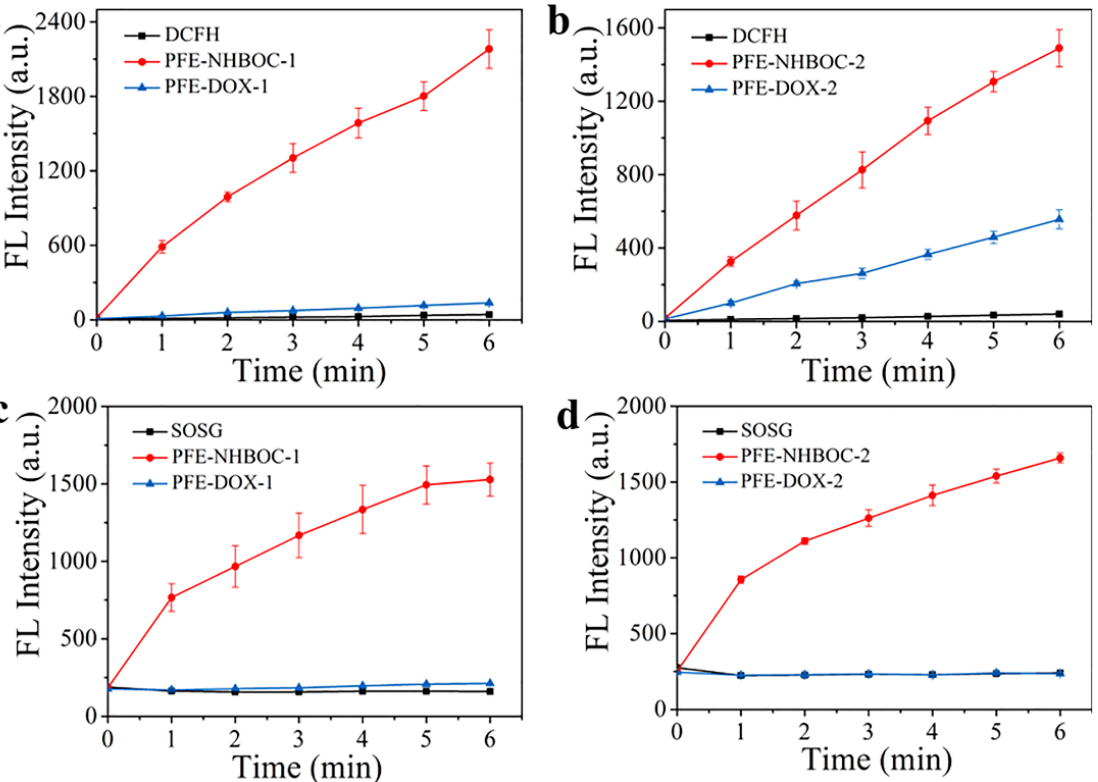
Figure 3 . Fluorescence intensity of DCFH at 525 nm in the presence of ( a ) PFE ‐ NHBOC ‐ 1 and PFE ‐ Figure 3. Fluorescence intensity of DCFH at 525 nm in the presence of ( a ) PFE-NHBOC-1 and DOX ‐ 1 and ( b ) PFE ‐ NHBOC ‐ 2 and PFE ‐ DOX ‐ 2 under white ‐ light irradiation (5 mW cm − 2 ) for 0–6 PFE-DOX-1 and ( b ) PFE-NHBOC-2 and PFE-DOX-2 under white-light irradiation (5 mW cm − 2 ) min: [polymer] = 1 μ M; [DCFH] = 40 μ M; λ ex = 488 nm. Fluorescence intensity of SOSG at 525 nm in